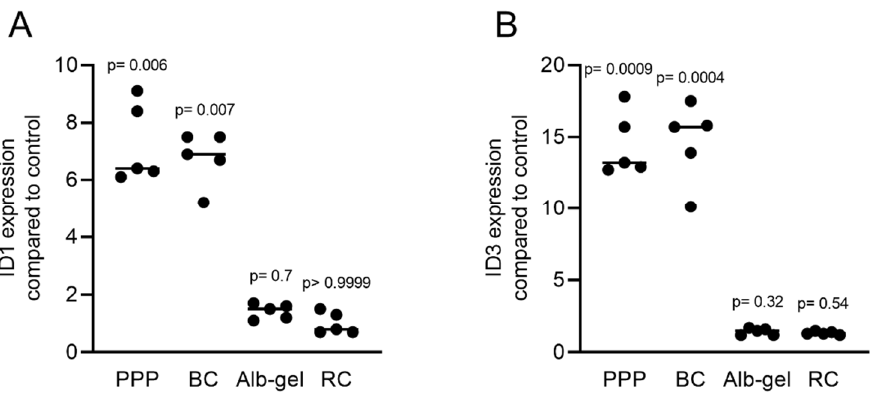
Figure 9. PRF lysates activate the expression of BMP2 and related genes ID1 and ID3. Gingival fibroblasts were treated with PPP, BC, Alb-gel, or RC, and TGF-β was used as the positive control. PCR analyses for ( A ) ID1 and ( B ) ID3 are presented. n = 5. Statistical analysis was based on the Kruskal–Wallis test for multiple comparisons.